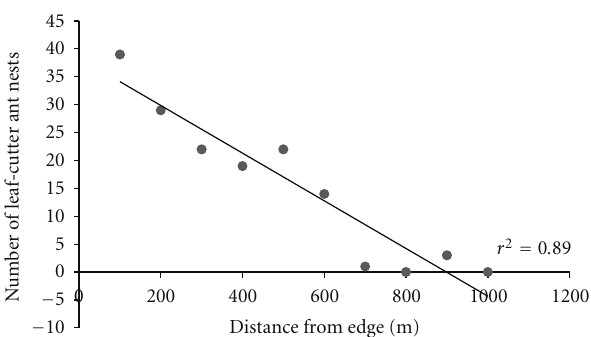
Figure 3: Number of leaf-cutter ant nests in relation to distance from the edge of a transitional forest at the Amazon-Cerrado boundary, N = 10.